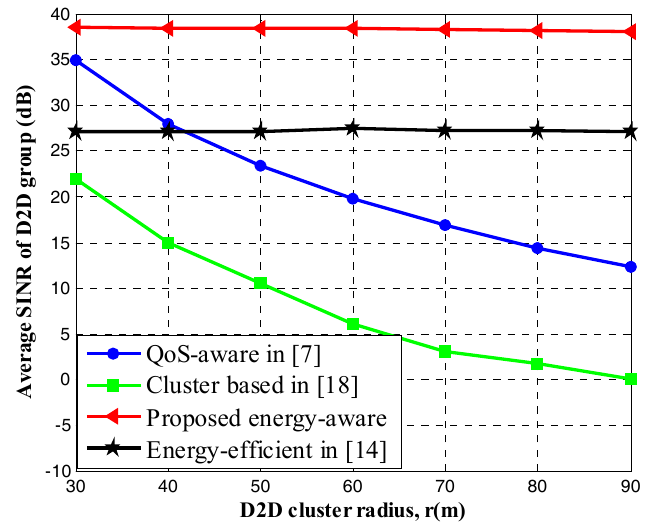
Figure 5. Average D2D group Energy efficiency versus number of group users.